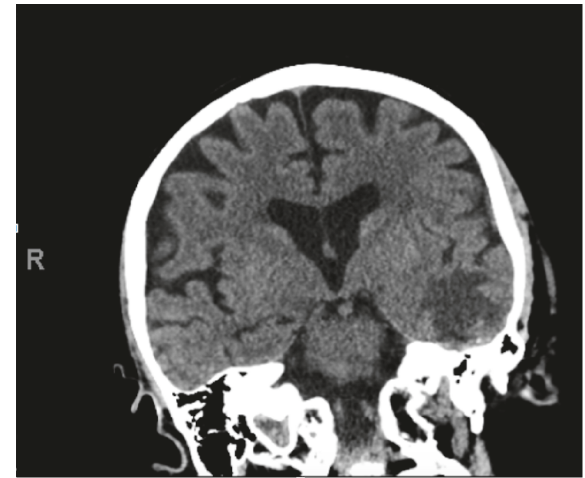
Figure 2: Coronal CT demonstrates hypodense left temporal lobe vasogenic edema.